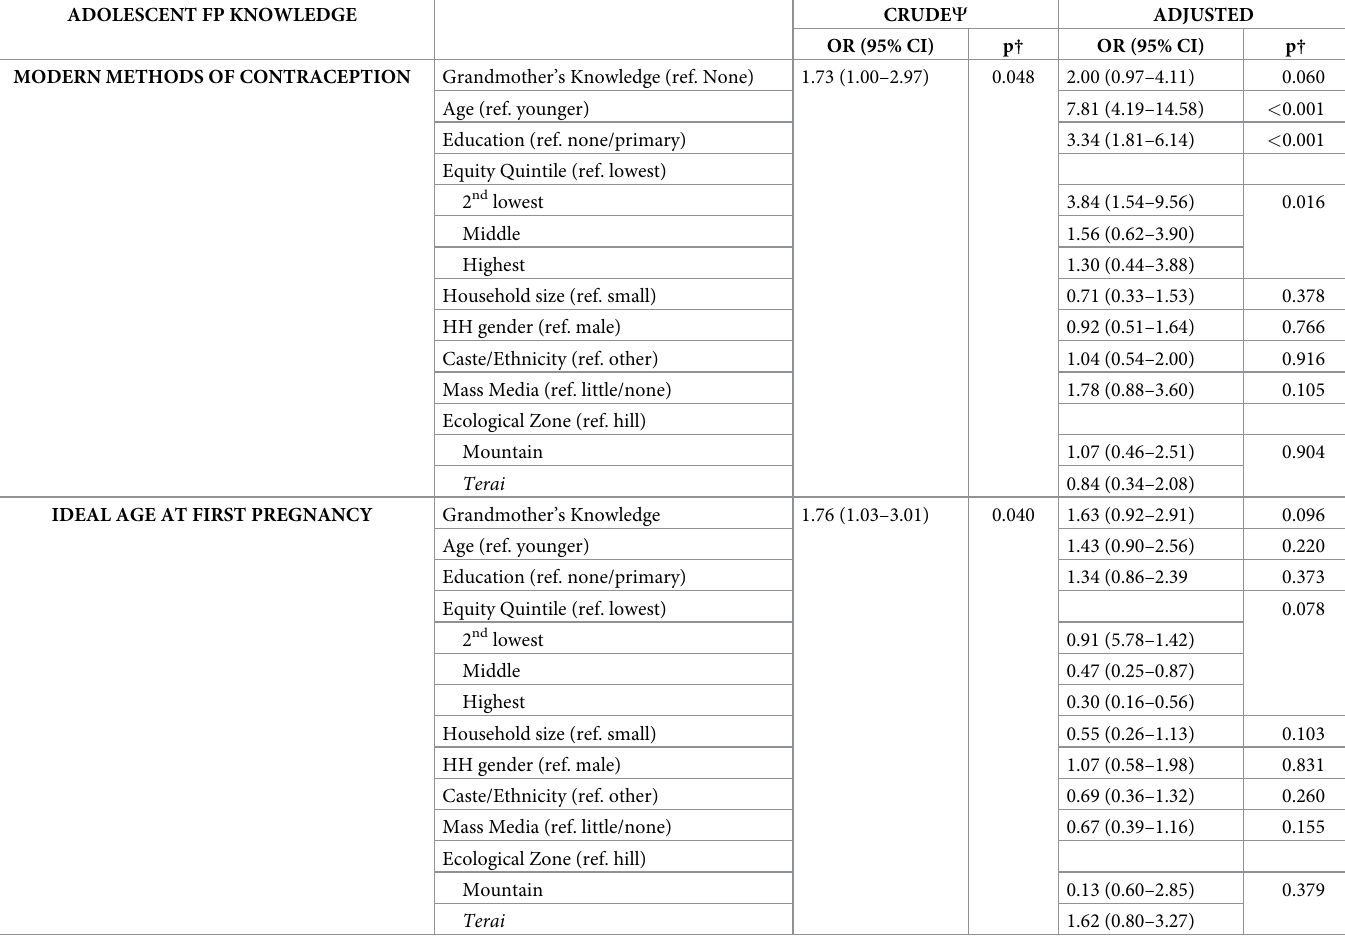
Table 5. Crude and multivariate associations between co-resident grandmothers’ FP knowledge and adolescent FP knowledge (n = 330). ADOLESCENT FP